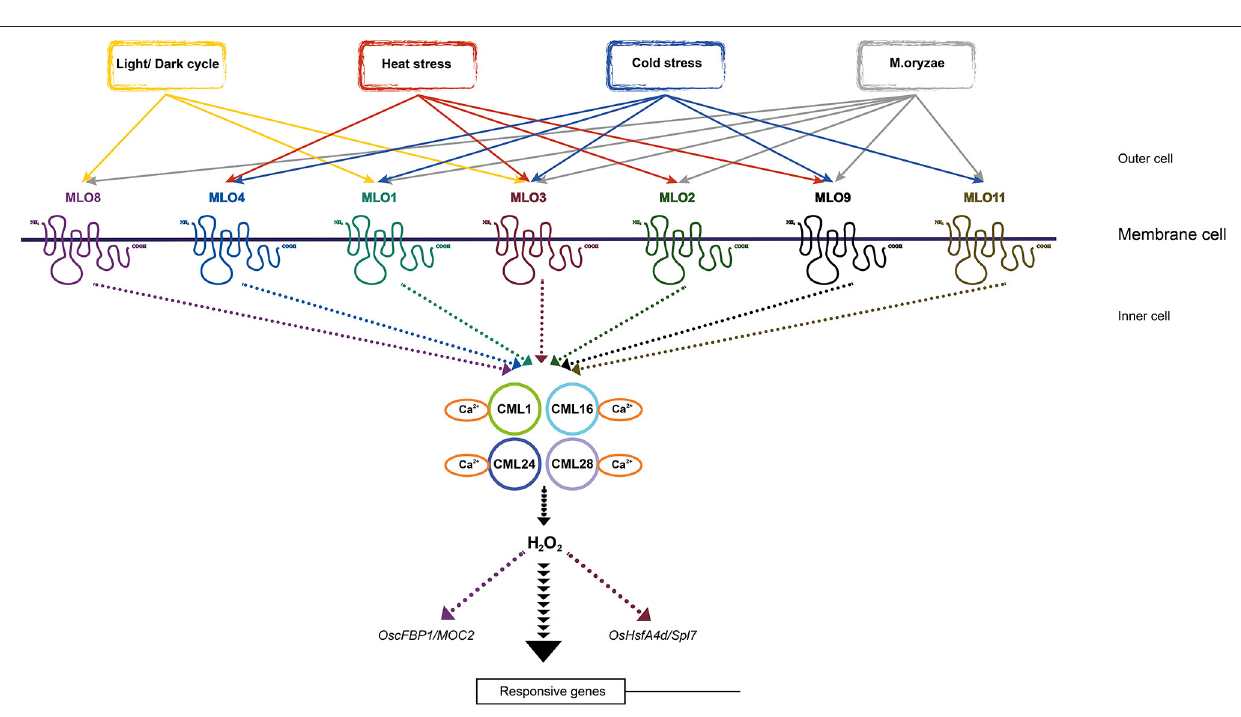
FIGURE 10 | Simplified model of OsMLO mediating stress-response pathways. Model includes 7 OsMLO genes that respond to different experimental conditions, plus OsCML genes in downstream signaling pathway of OsMLO family genes and potential responsive genes in signaling pathways. OsHsfA4d / Spl7 and OscFBP1 / MOC2 were presented as downstream factors of OsMLO3 and OsMLO8 , respectively. Solid arrows show relationships analyzed in this study; dashed arrows indicate unclear relationships. Individual MLO pathway was indicated by different